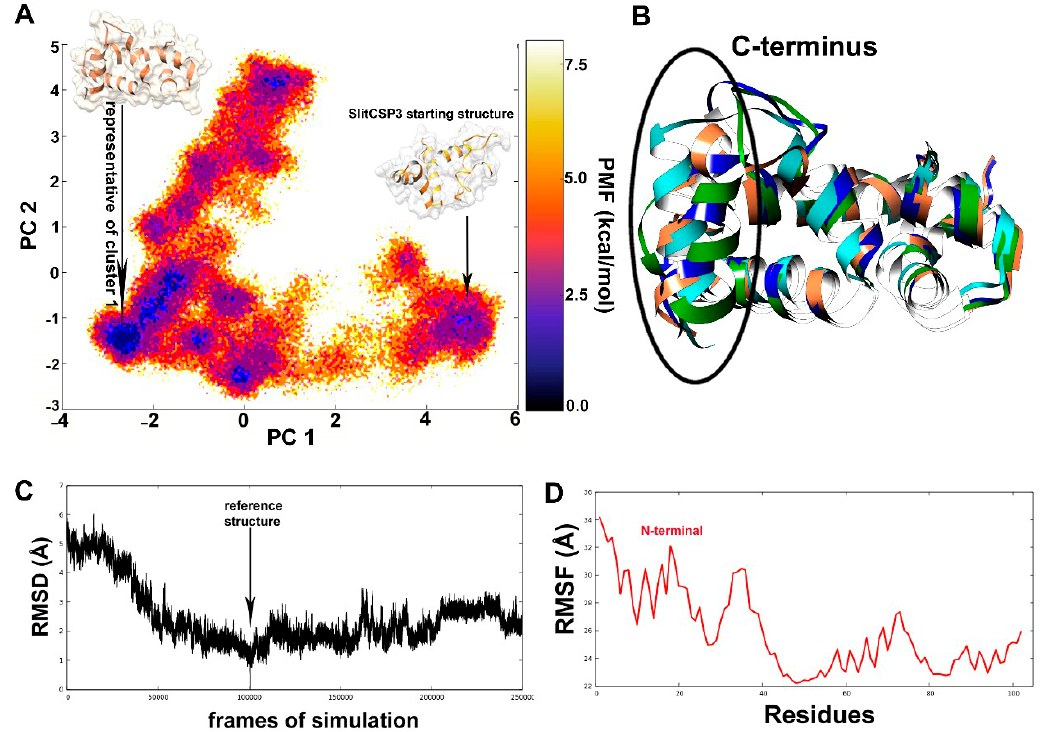
Figure 2. ( A ) Free energy landscape obtained from the dihedral principal component analysis of the 500 ns long accelerated MD simulation. The potential-of-mean force (PMF) stands for the change in free energy upon conformational transitions. The representative structure of cluster 1 was chosen for all further studies. ( B ) The superimposed cartoon representation of the top clusters. The major conformational differences can be seen in the C-terminus. ( C ) The root-mean-square deviation calculated for the whole trajectory to assess its stability. ( D ) The root-mean-square atomic fluctuation calculated for all residues indicates that major changes occurred at the N-terminus through its folding pathway.